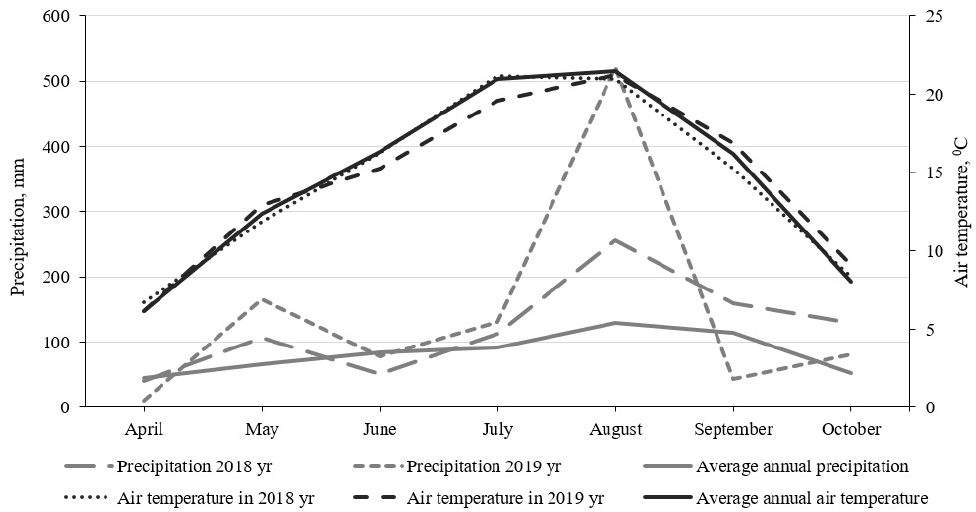
Figure 1. Average air temperature and total precipitation during the growing seasons of 2018 and 2019 in the area of Primorsky Krai (https://rp5.ru accessed on 8 April 2021). According to the average monthly value of air temperature, both the growing season of 2018 and 2019 did not have significant differences compared to the average long-term values (Figure